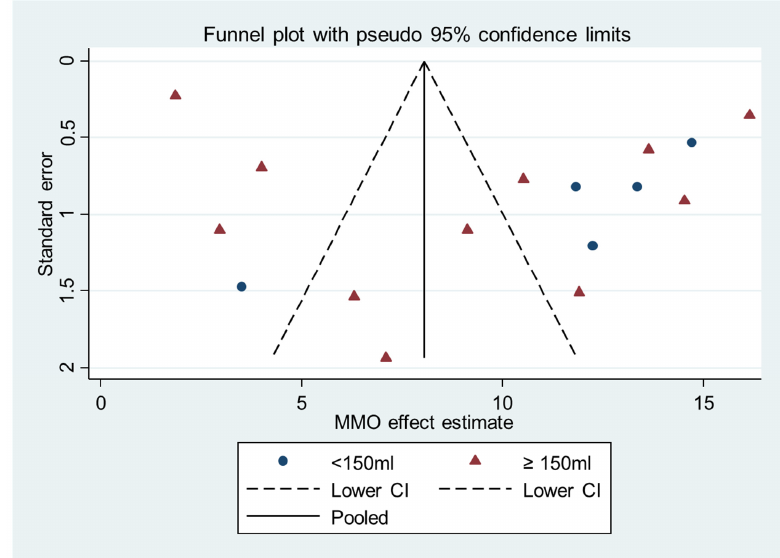
Figure 4. Funnel plot of the MMO mean differences. Diagnostics 2022 , 12 , x FOR PEER REVIEW